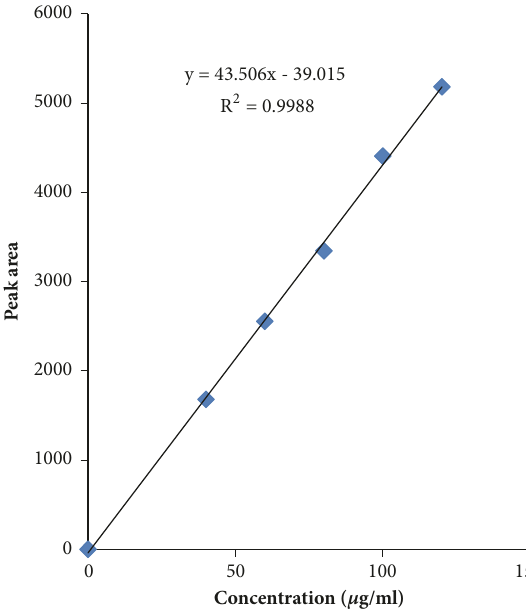
Figure 8: Calibration curve of